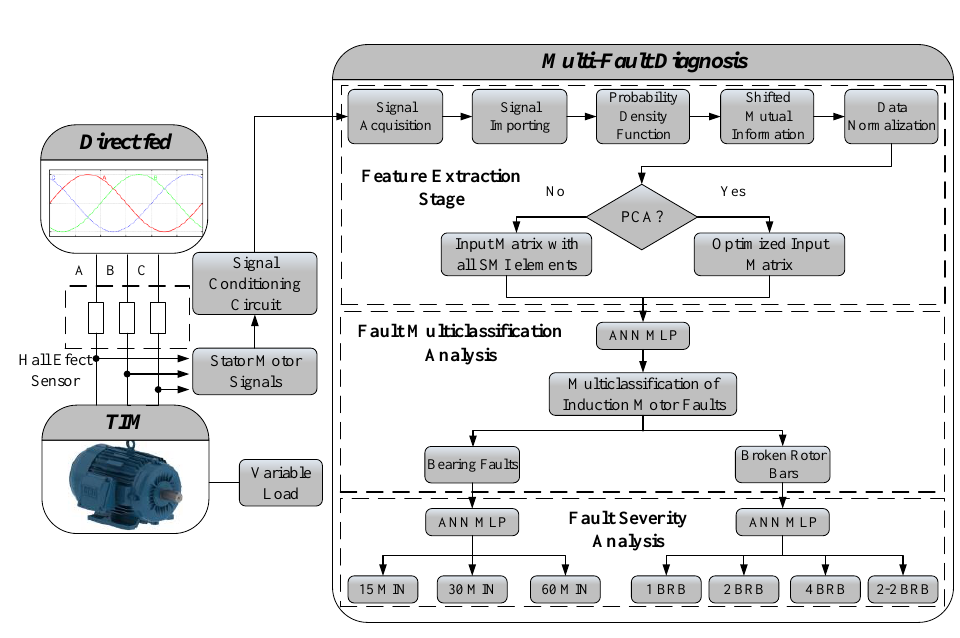
Figure 3. Block diagram of the proposed methodology used in this